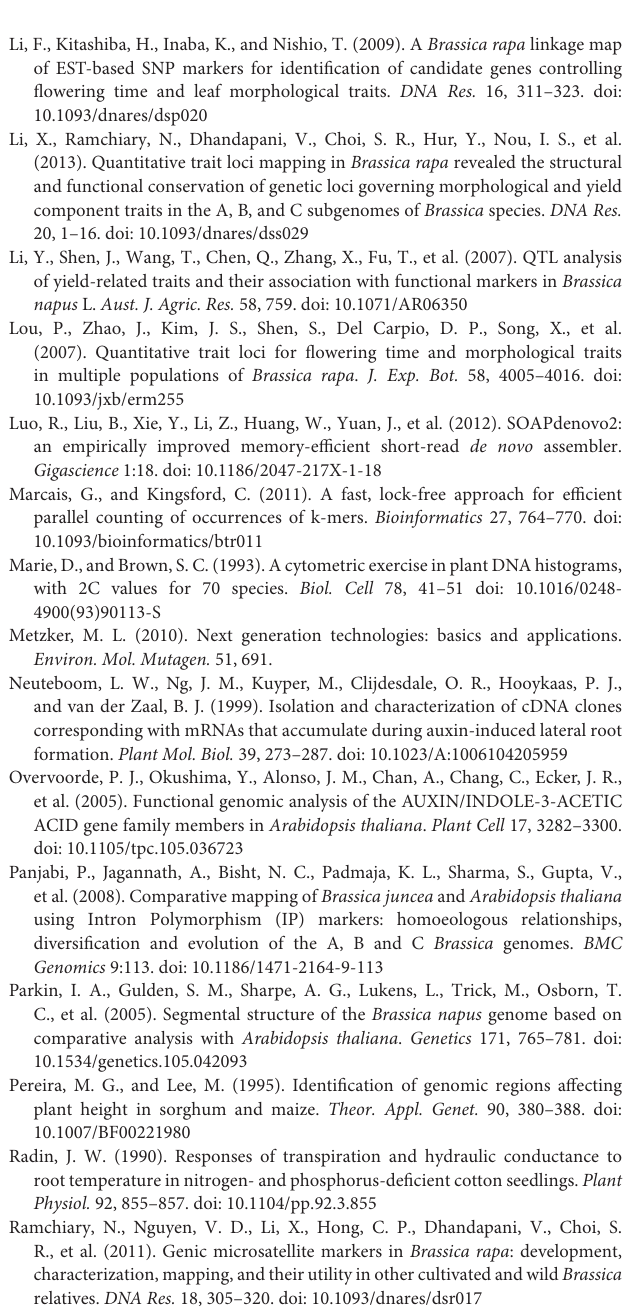
arrows indicate “835” and diamond